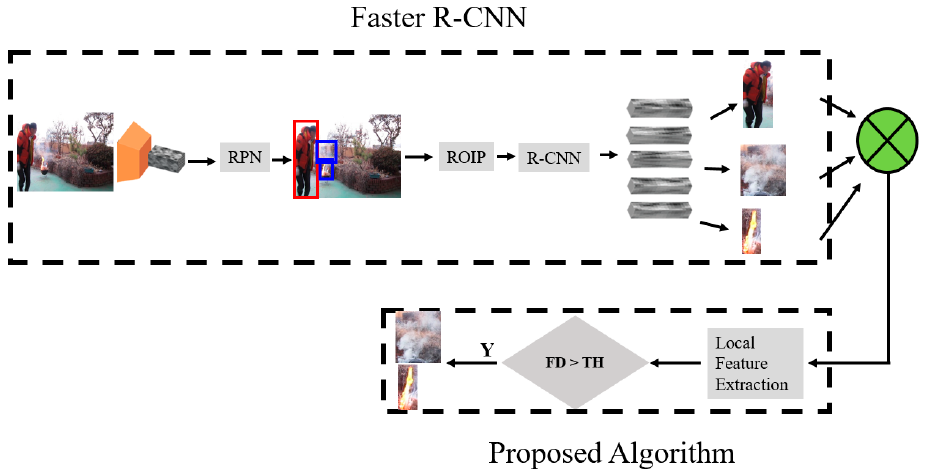
Figure 2. Faster R-CNN system flow.